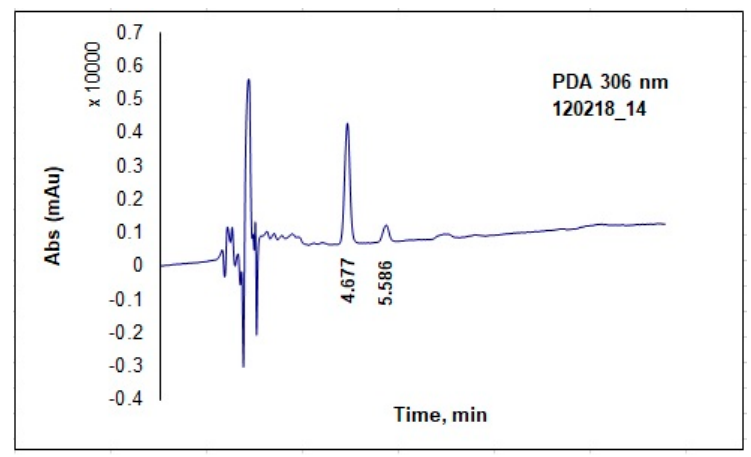
Figure 1. Typical chromatogram of sample solution.